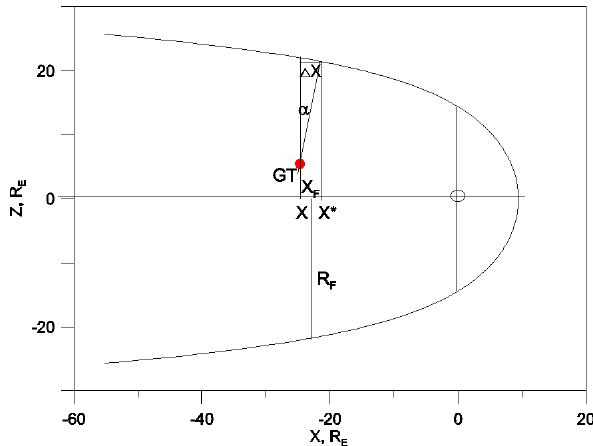
Fig. 1. The scheme presenting the geometry of Geotail measure- ments for the day–night meridian. X is the Geotail position, X ∗ – the magnetopause coordinate, corresponding to the same B L / α val- ues, X F = 0 . 5 (X + X ∗ ) and R T (X F ) = 0 . 5 (R T (X) + R T (X ∗ )) – the quantities used when calculating the tail magnetic